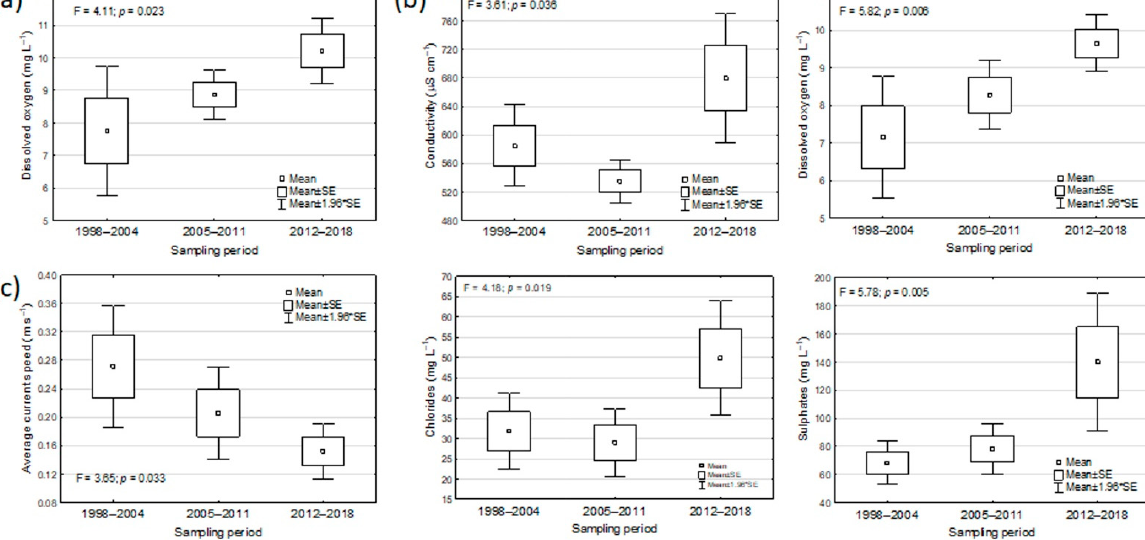
Figure 7. Ecological requirements: trend over time of the mean values of: dissolved oxygen for Barbus barbus ( a ); conductivity and dissolved oxygen for Padogobius bonelli ( b ); average current speed, chlorides, and sulphates for Pseudorasbora parva ( c ). For each species, only the occurring sites in the census periods 1998–2004, 2005–2011, 2012–2018 were considered. Only statistically significant results at ANOVA are shown.